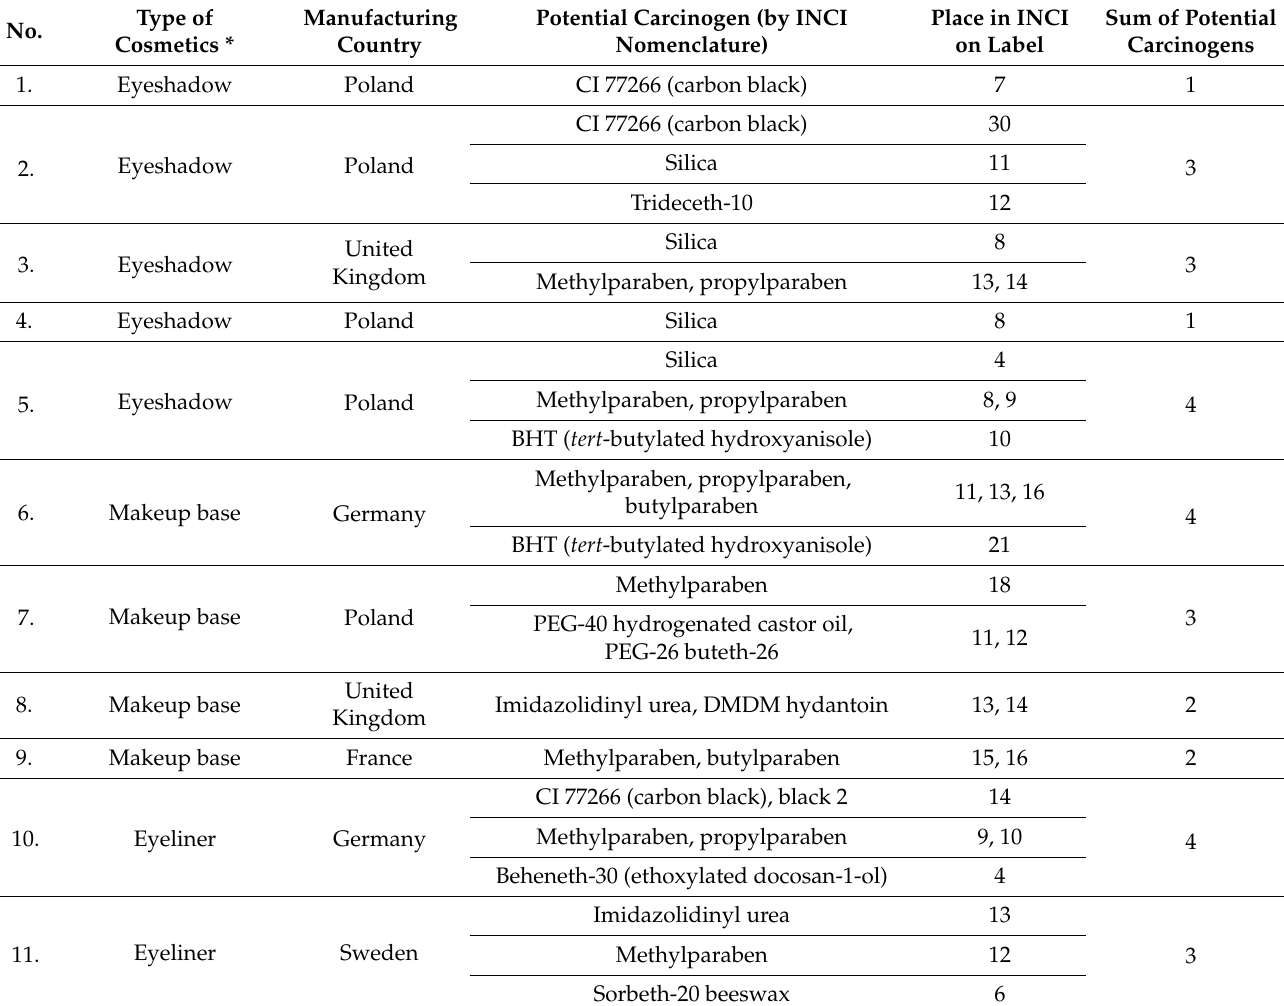
Table 1. Analysis of the INCI ingredients of selected cosmetic products for facial